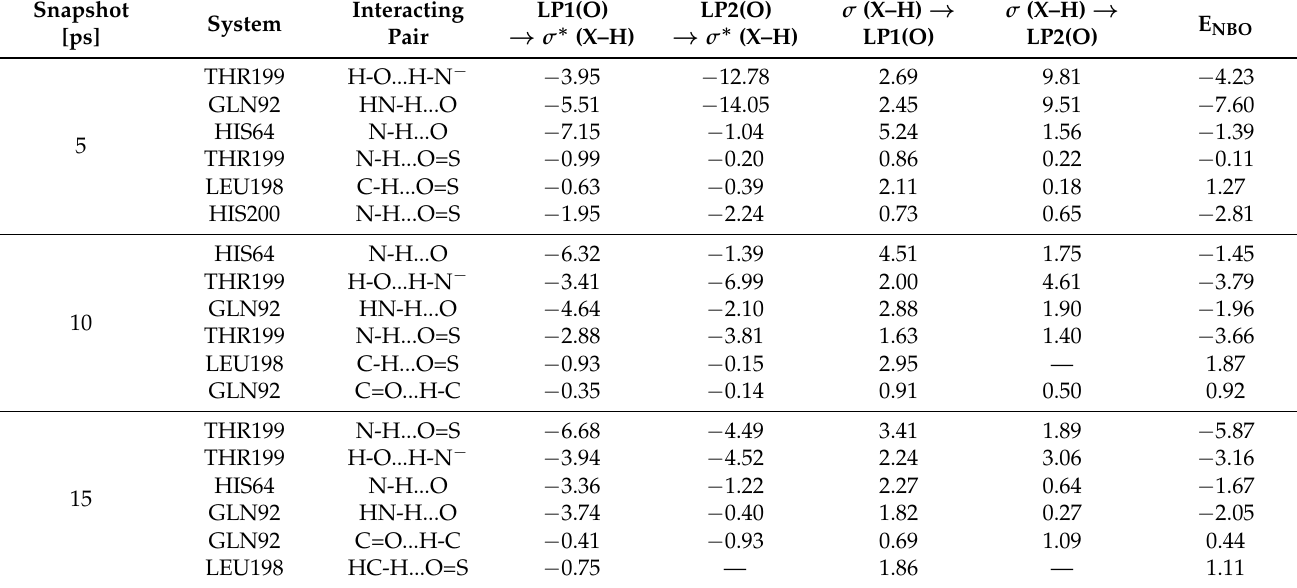
Table 2. Natural Bond Orbitals (NBO) interaction and steric repulsion energies estimation between the lone pairs of the oxygen acceptor atom and the antibonding σ ∗ (X–H) or bonding σ (X–H) orbital of the amino acids of the CA I binding site (large model) and the Topiramate ligand. E NBO is defined as a sum of attractive and repulsive components to the energy. All energies are provided in